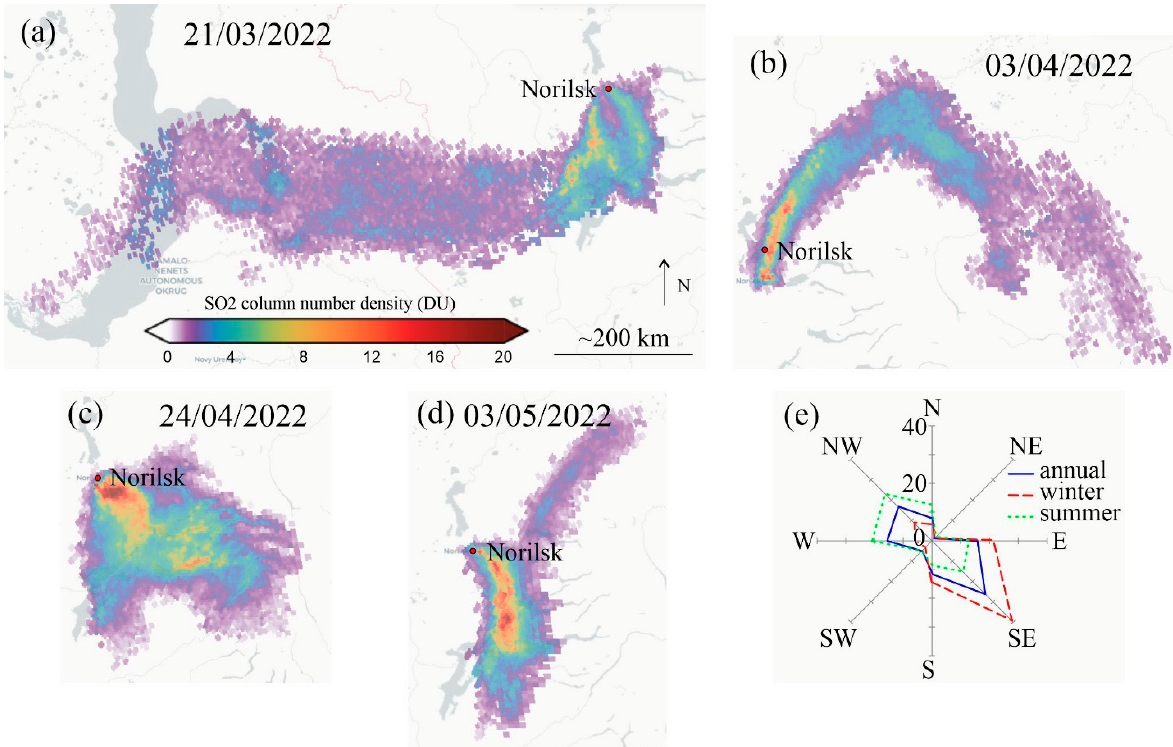
Figure 5. ( a – d ) Examples of sulfur dioxide transfer (based on Copernicus Sentinel-5P data [25]). SO 2 pollution spreads to a distance of several hundred km. The scale of SO 2 concentrations at the 7 km altitude is presented in ( a ). ( e ) The wind rose. Northwestern wind prevailed in summer, whereas southeastern ones prevailed in winter.